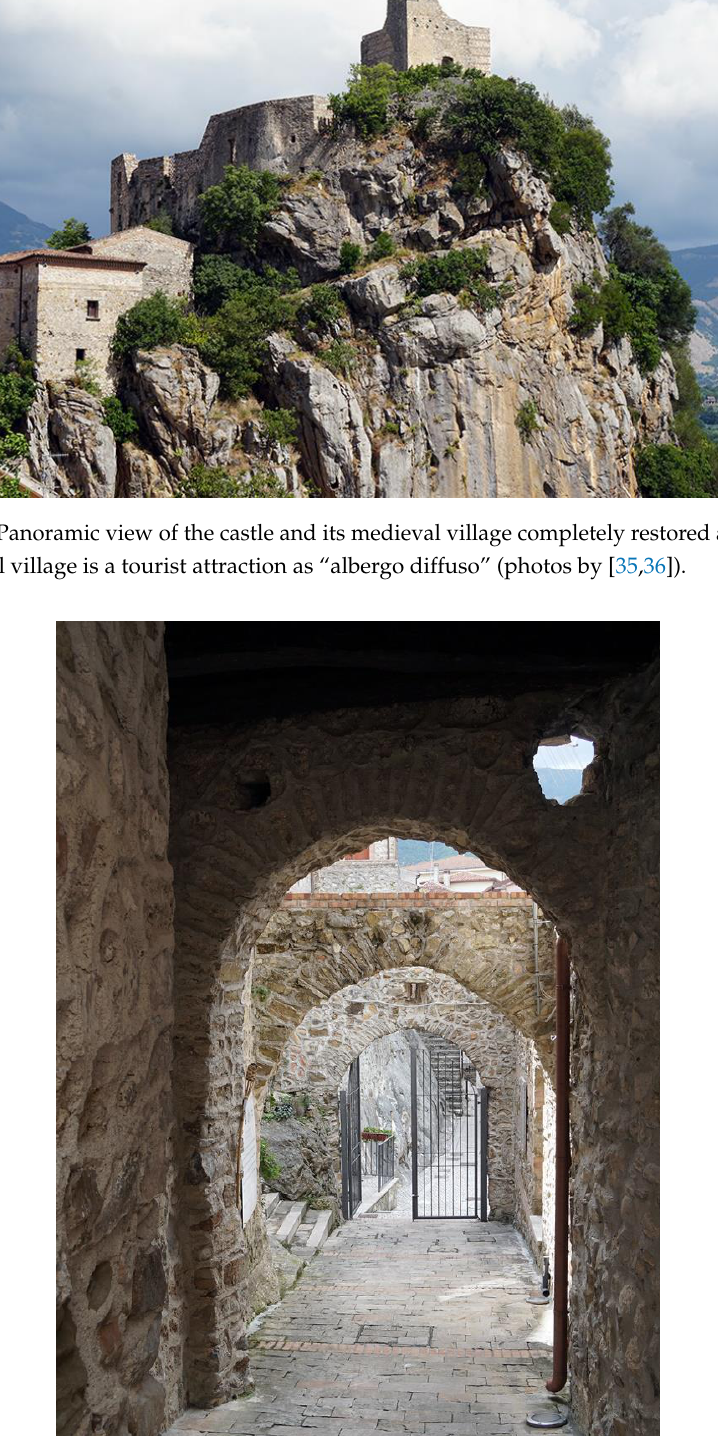
Figure 52. Quaglietta: detail of the medieval village (photos by [35,36]).